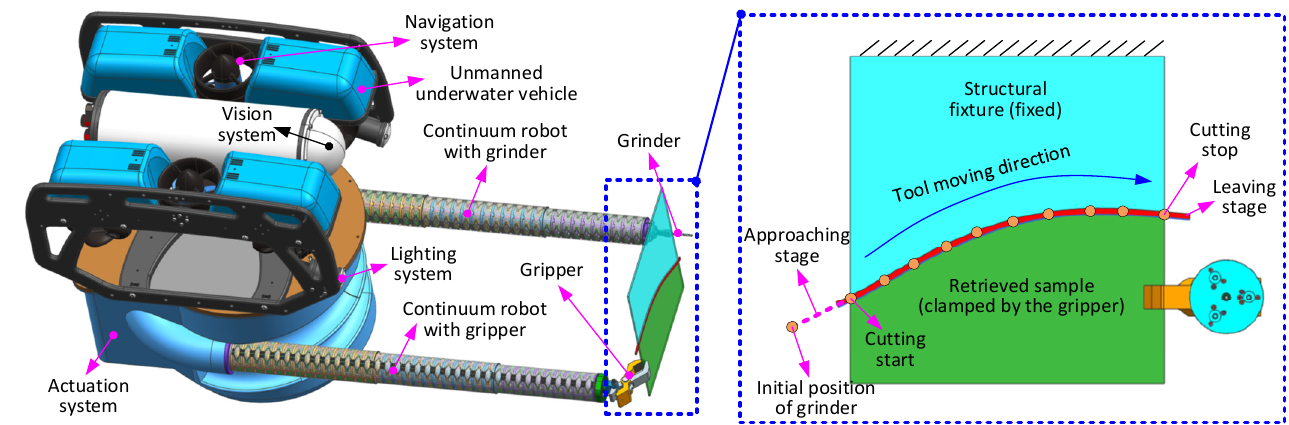
Figure 4. Cooperative workspace of the dual-arm continuum robot: ( a ) is the overall view of the workspace for the two continuum robots; ( b ) is the section view of the cooperative workspace. Note: for visibility, the bending ranges for the three sections of the two continuum robots in ( a ) are 30°, 45°, and 60°, respectively, while it is 90° in ( b ). The phase angles are within [0°, 360°] in both ( a ) and ( b ).